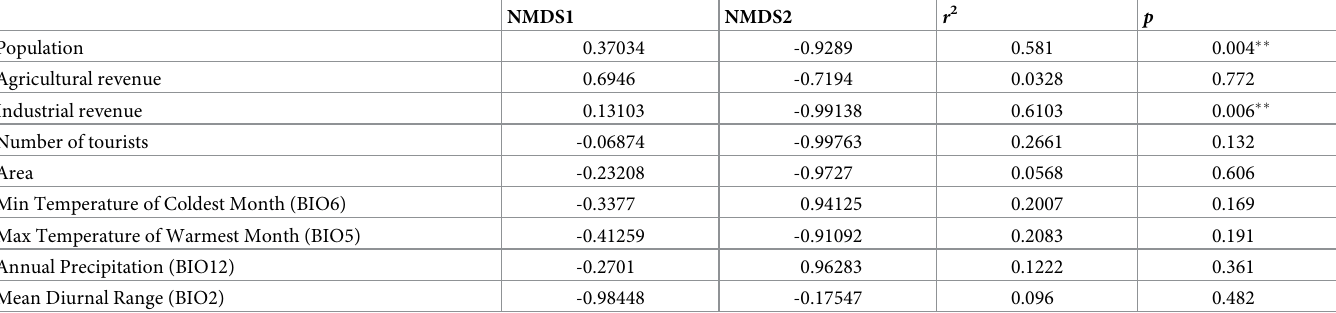
Table 5. Non-metric multidimensional scaling (NMDS) analyses of the endemic species in 18 administrative units and the environmental